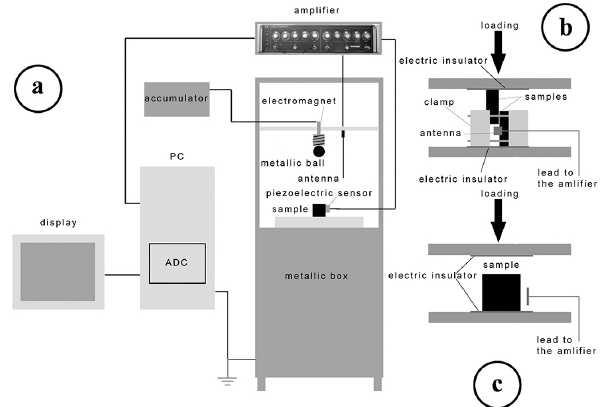
Figure 1. Diagram of the experimental setup. (a) Impact action on samples, (b) rubbing of two samples, (c) gradual